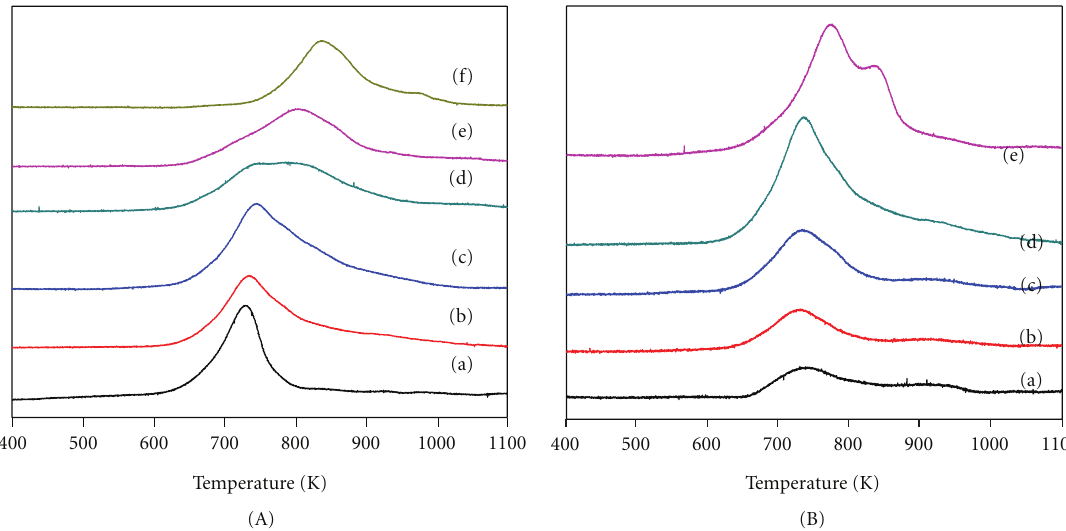
Figure 4: TPR profiles of Cd 1 − x Zn x S / SiO 2 with di ff erent composition (A): (a) x = 0, (b) x = 0.2, (c) x = 0.4, (d) x = 0.6, (e) x = 0.8, and (f) x = 1 and of Cd 0 . 8 Zn 0 . 2 S/SiO 2 sample calcined at di ff erent temperature (B): (a) 393 K, (b)623K, (c)673K, (d)723K, and (e)773K.